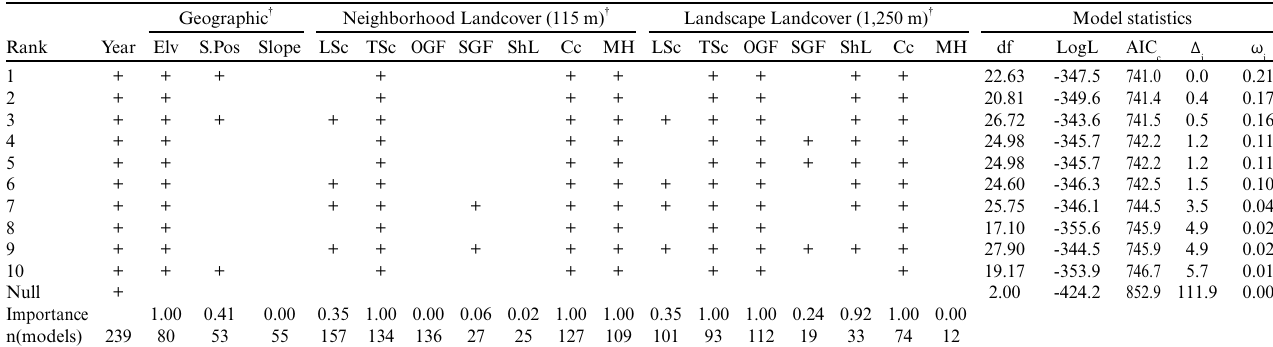
Table 2 . Best model set (i.e., models having cumulative weights summing to 0.95) to explain habitat use by Gray-cheeked Thrushes (Catharus minimus minimus) in the Main River watershed in western Newfoundland, 2006-2007. The importance of individual explanatory variables, which represents the sum of the weights of all models containing each term, as well as the number of models containing each explanatory variable, are presented at the bottom. See Table 1 for descriptions of explanatory